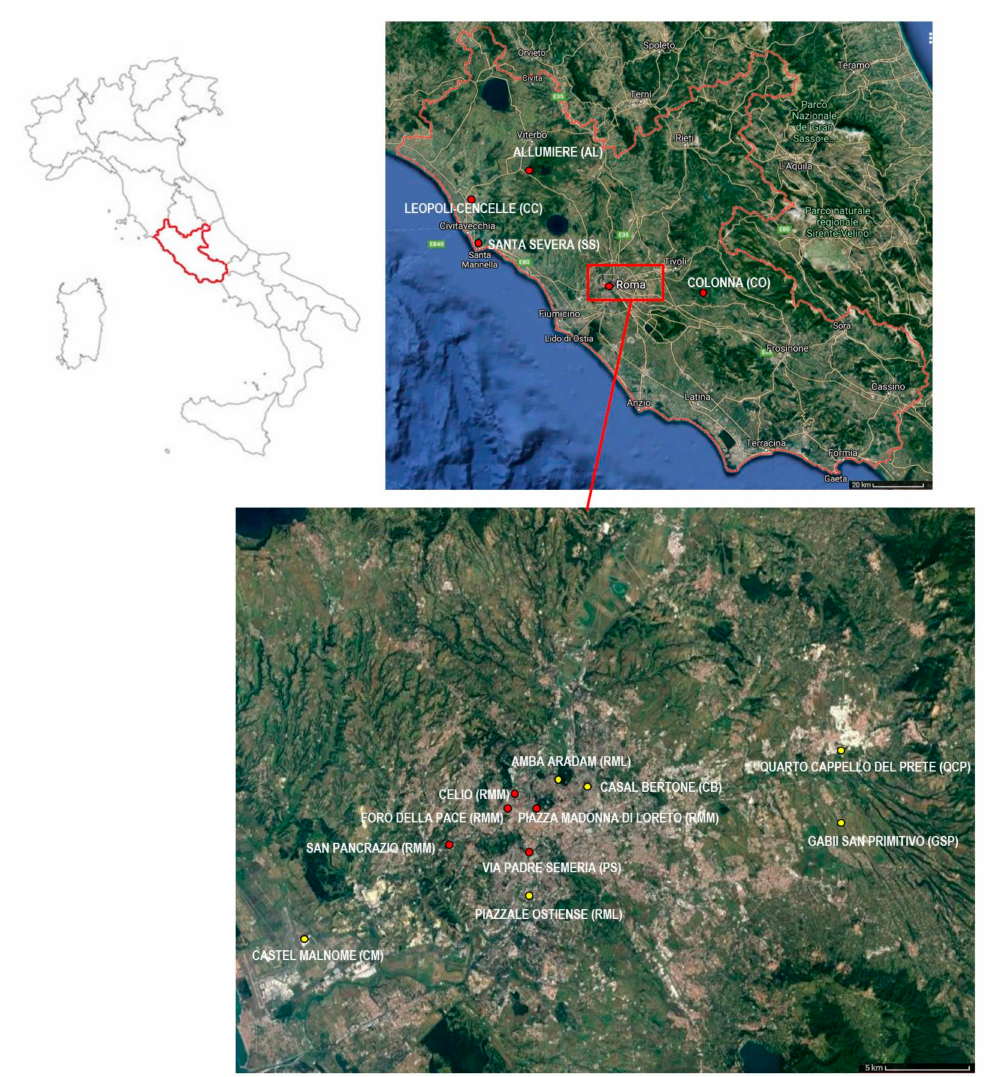
Figure 1. Location of the Latium region and of the Roman Imperial (yellow dots), and Medieval (red dots) sites analyzed in the present research (modified from https://www.google.it/maps, accessed on 19 March